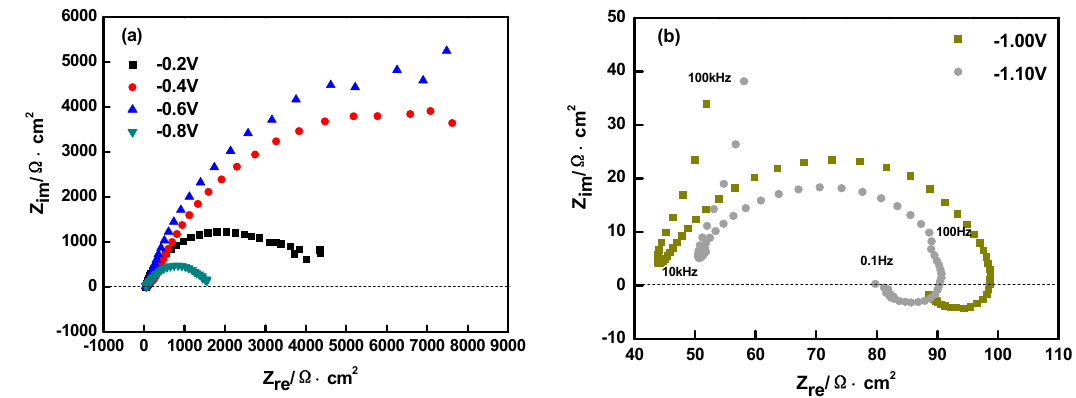
Figure 6. Nyquist curves for Ni-Co-ZrO 2 multiple coatings electroplated on copper surface, ( a )